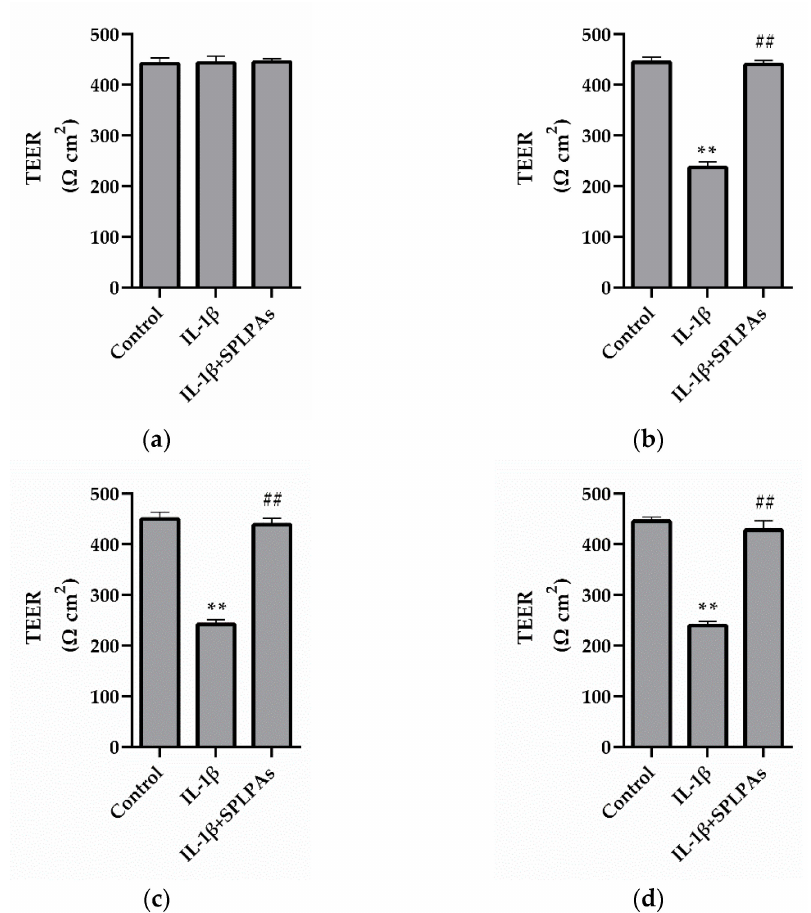
Figure 5. The barrier function of the Caco-2 cell monolayer was investigated with TEER values were recorded at 0 h ( a ), 6 h ( b ), 12 h ( c ), and 24 h ( d ) after IL-1 β treatment. ** p < 0.01 vs. the control group. ## p < 0.01 vs. the IL-1 β (10 ng/mL)